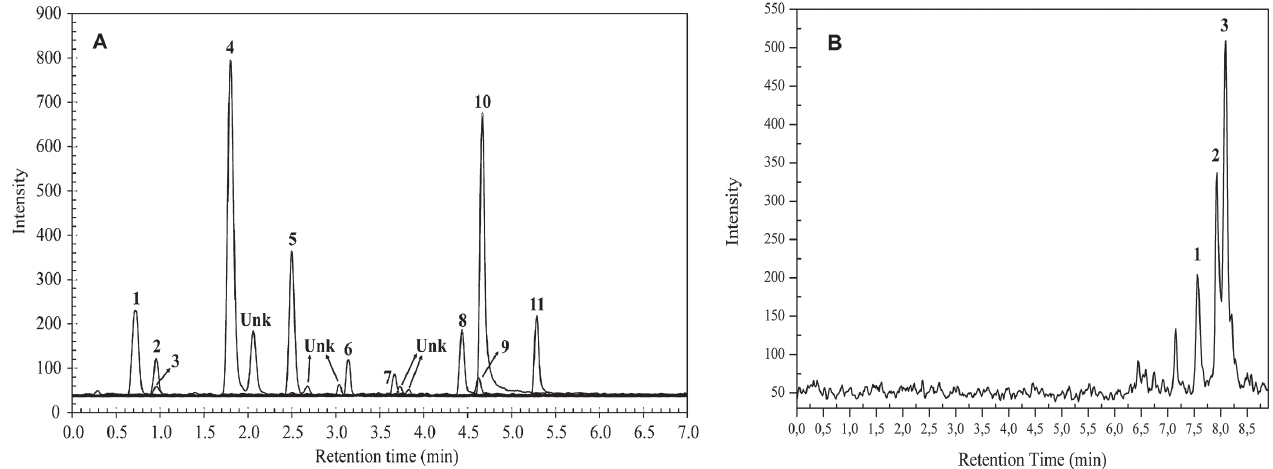
FIGURE 1 - (A) Chromatograms obtained for the analysis of the hydroalcoholic extract of Jatropha gossypiifolia L. (first harvest) by UHPLC-ESI-MS/MS in MRM mode. Column: Zorbax SB C18 2.1x50 mm (1.8 μm) . Gradient elution with 0.1% acetic acid in water (A) and acetonitrile (B) as the mobile phase at a constant flow rate (0.8 mL min –1 ) according to the following elution program: 8.0% B (0.00–0.10 min); 8.0–25.8% B (0.10–3.45 min); 25.8–54.0% B (3.45–6.90 min); 54.0–100.0% B (6.90–7.00 min); and 100.0% B (7.00–9.00 min). Phenolic compounds identified: (1) Catechin, (2) Caffeic acid, (3) Vanillic acid, (4) p -coumaric acid, (5) Ferullic acid, (6) Rutin, (7) Quercitrin, (8) trans-cinnamic acid, (9) Quercetin, (10) Luteolin, (11) Apigenin. (B) Chromatograms obtained from UHPLC-APPI-MS/MS analysis of the hydroalcoholic extract of Jatropha gossypiifolia L. (first harvest) in MRM mode. Column: Zorbax SB C18 2.1x50 mm (1.8 μm) . Mobile phase gradient: 70% acetonitrile/water from zero to 3.5 min and 100% acetonitrile after 4.0 min (8 min run). Flow rate gradient: 0.6 mL min-1 from zero to 4 min and 0.8 mL min-1 after 5 min run (8 min run). Triterpenic compounds identified: (1) lupeol, (2) β - amyrin , (3) α -